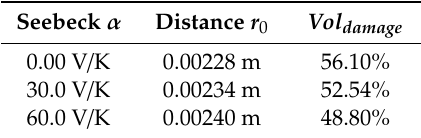
Table 9. The irreversible thermal damage of liposarcoma tumor with various Seebeck coe ffi cients and at voltage V = 78V and time t = 150 s.